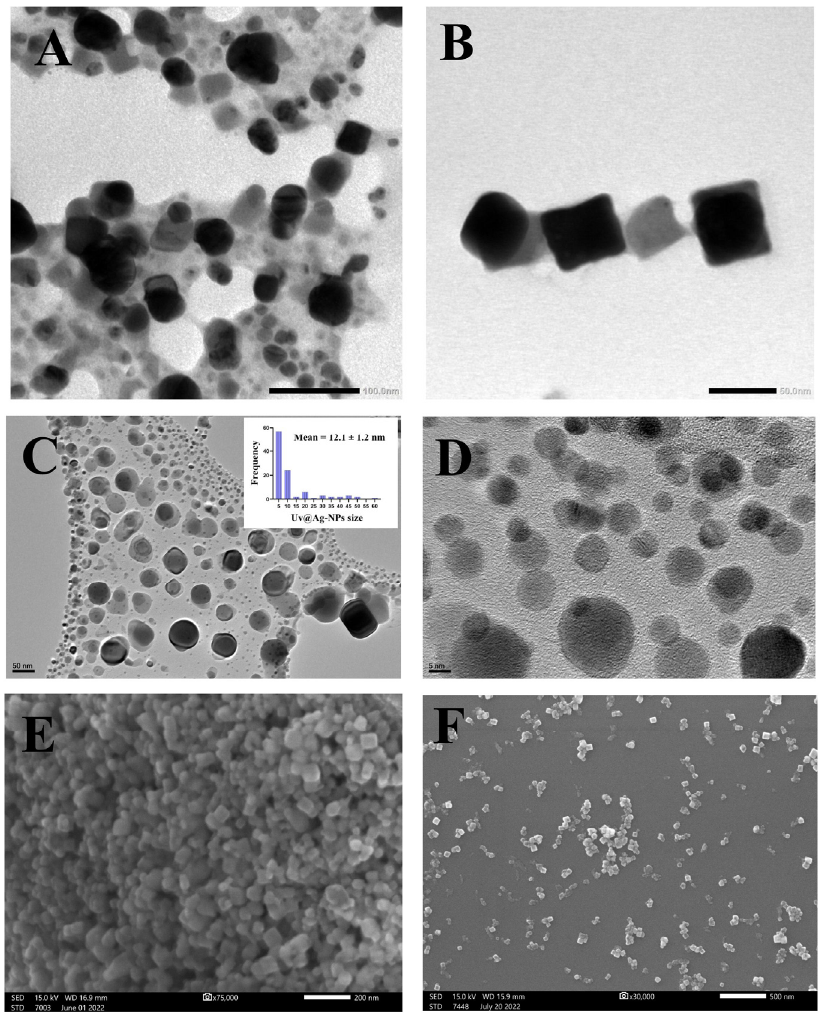
Figure 6. TEM ( A , B ), HR ‐ TEM ( C , D ), and SEM ( E , F ) micrographs of Uv@Ag ‐ NPs illustrate the uni ‐ form distribution of Uv@Ag ‐ NPs and their spherical and cubic shapes. Scale bar = 100 nm ( A ), 50 nm ( B , C ), 5 nm ( D ), 200 nm ( E ), and 500 nm ( F ). 50 nm ( B , C ), 5 nm ( D ), 200 nm ( E ), and 500 nm ( F